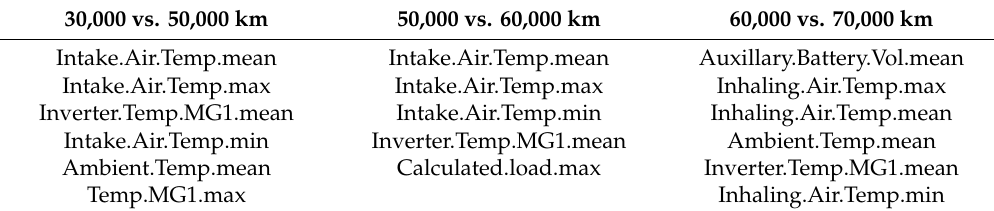
Table 7. Important features per mileage interval